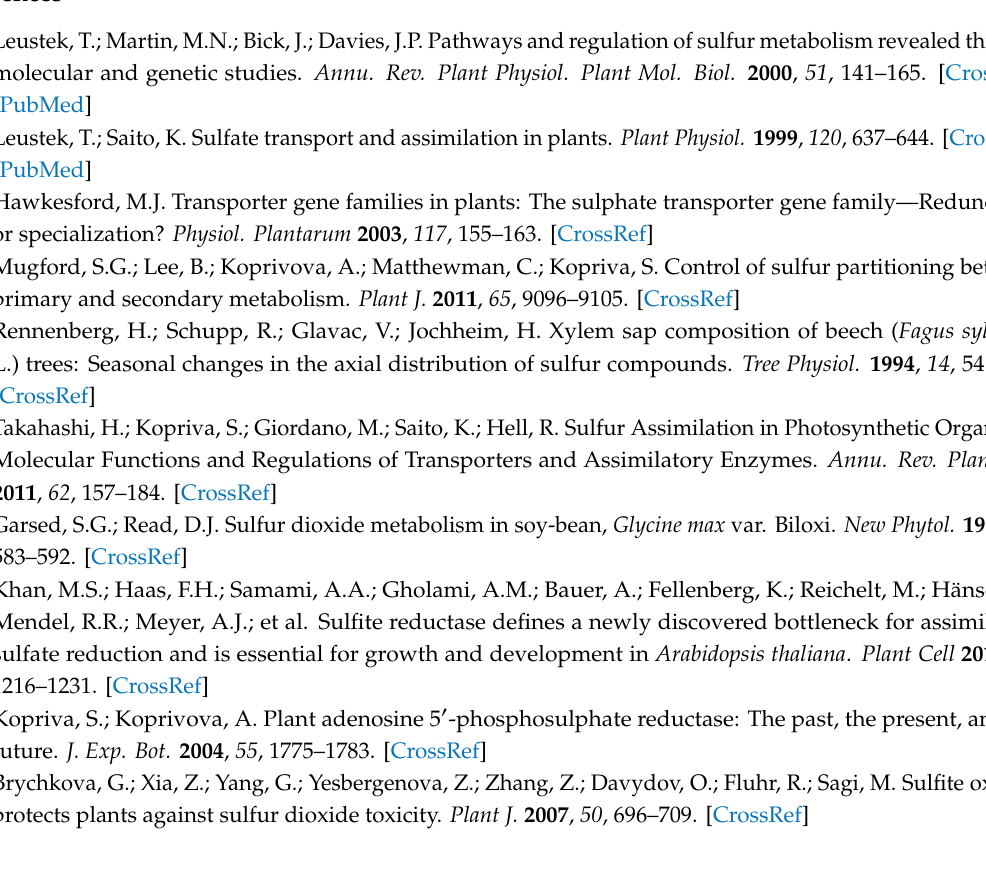
Figure S1: Total biomass of tomato wild type (RR), SO OE (OE 13-6 / 6 and OE 12-5 / 7) and SO Ri (Ri 421 and Ri 131) lines was measured after harvesting the fruits at the end of the experiment, 93 days after transplanting. The values are averages ± SE ( n = 9). Di ff erent letters show significant di ff erence at p < 0.05; Figure S2: Total fruit yield per plant was recorded for wild type (RR), SO OE (OE 13-6 / 6 and OE 12-5 / 7) and SO Ri (Ri 421 and Ri 131) lines. The values are averages ± SE ( n = 10). Di ff erent letters show the significant di ff erence at p < 0.05; Table S1: Total soluble solids (TSS) were detected in wild type (RR), SO OE (OE 13-6 / 6 and OE 12-5 / 7), SO Ri (Ri 421 and Ri 131) lines. The values are means ± SE ( n = 10). Di ff erent letters show significant di ff erences at p <